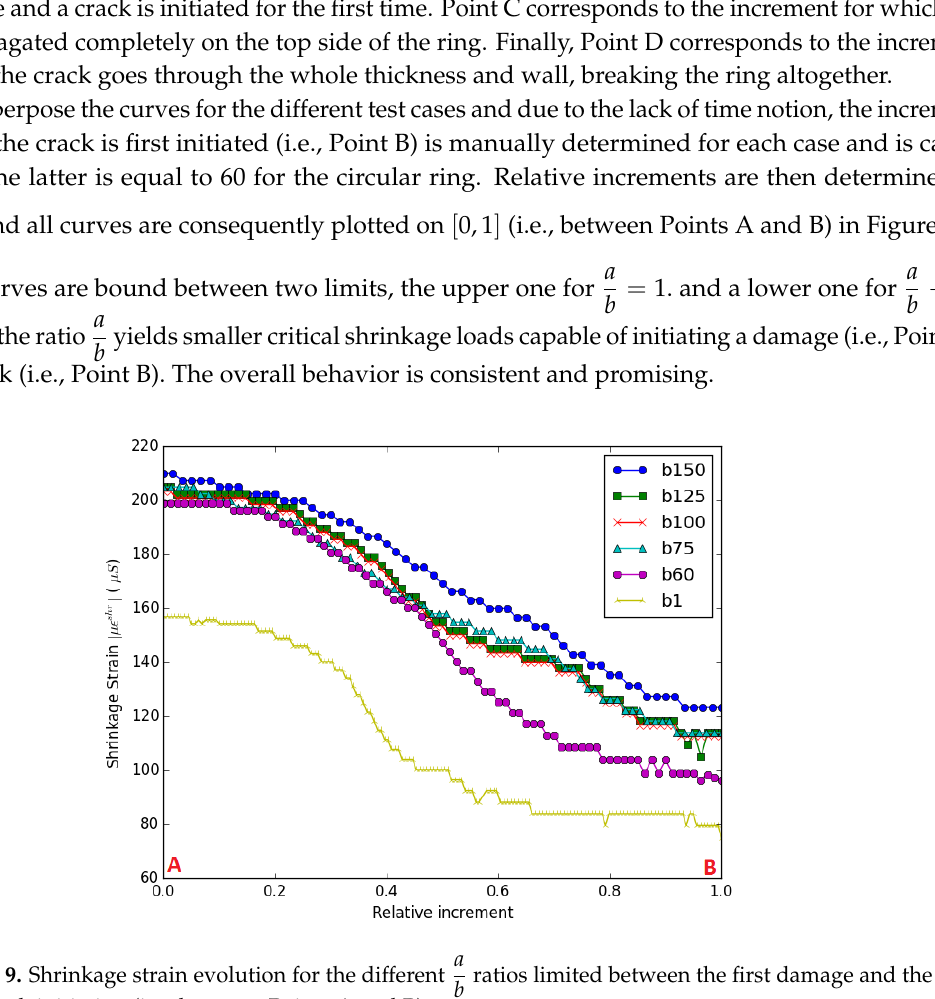
Figure 9. Shrinkage strain evolution for the different first crack initiation (i.e., between Points A and